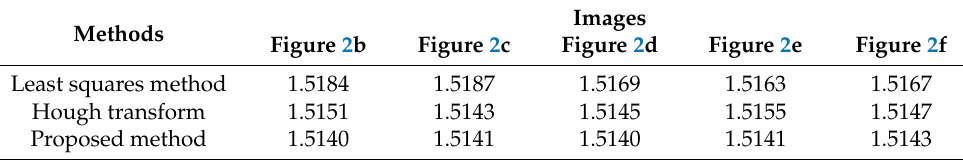
Table 1. The time to detect multiple circles by different algorithms. Methods Least squares method Hough transform